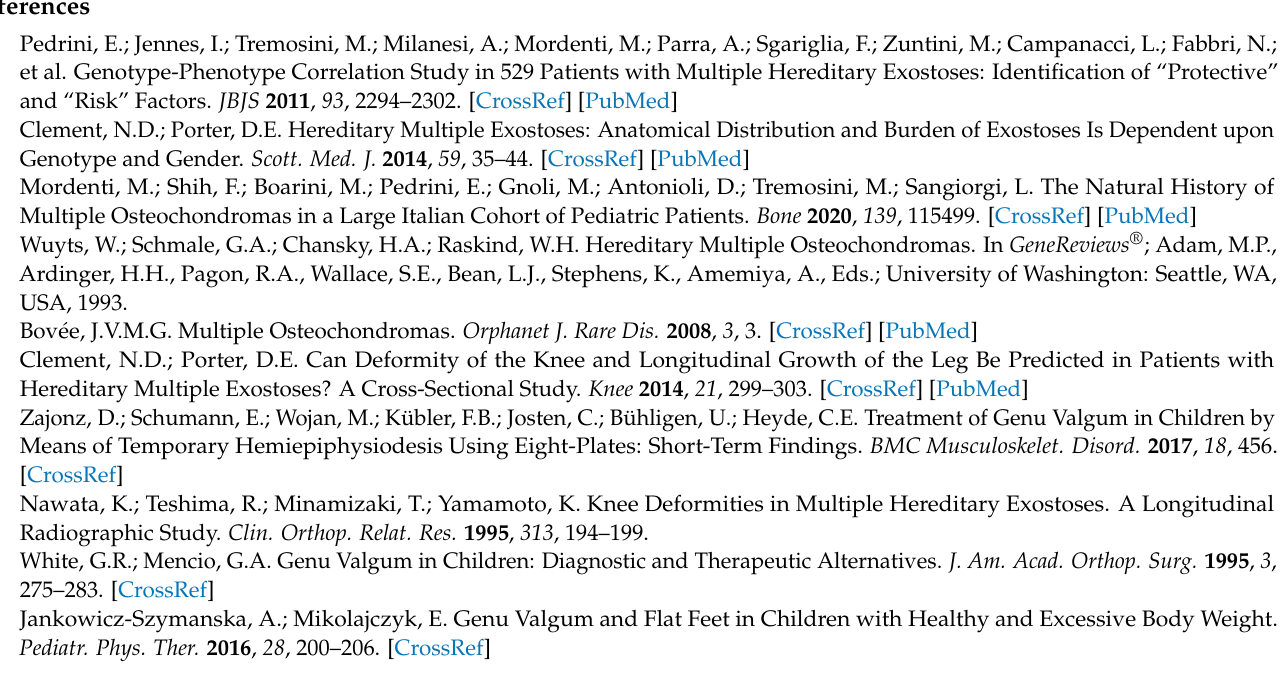
classification system [27,28]. Table S4: Predictors of MAD (%) and correction velocity. Multivariable linear regression models. Table S5: Adjustment comparisons between the MO versus idiopathic cohort on postoperative MAD and correction velocity with linear regression